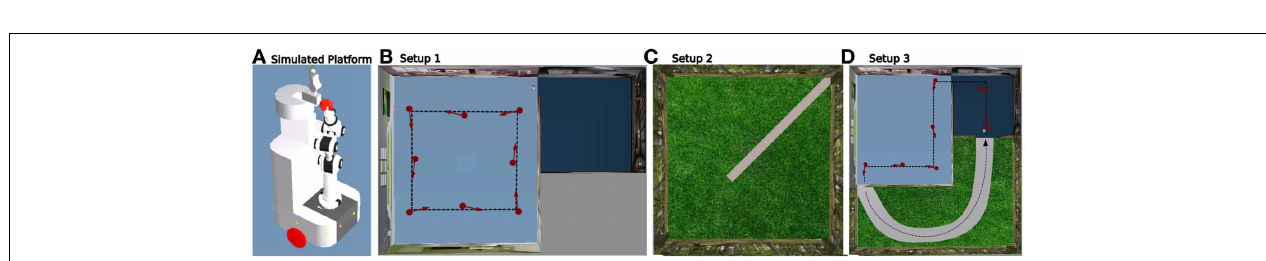
FIGURE 6 | Setup in Webots simulated environments. (A) Robotic platform used in our simulations. (B) Setup 1 used to test the place/action strategy. The system evolves in a simulated room of 15 x 15m. It learns a few places associated with different actions (in red) to perform an ideal round behavior (black dotted line). (C) Setup 2 used to test the road following strategy. The system evolves in a